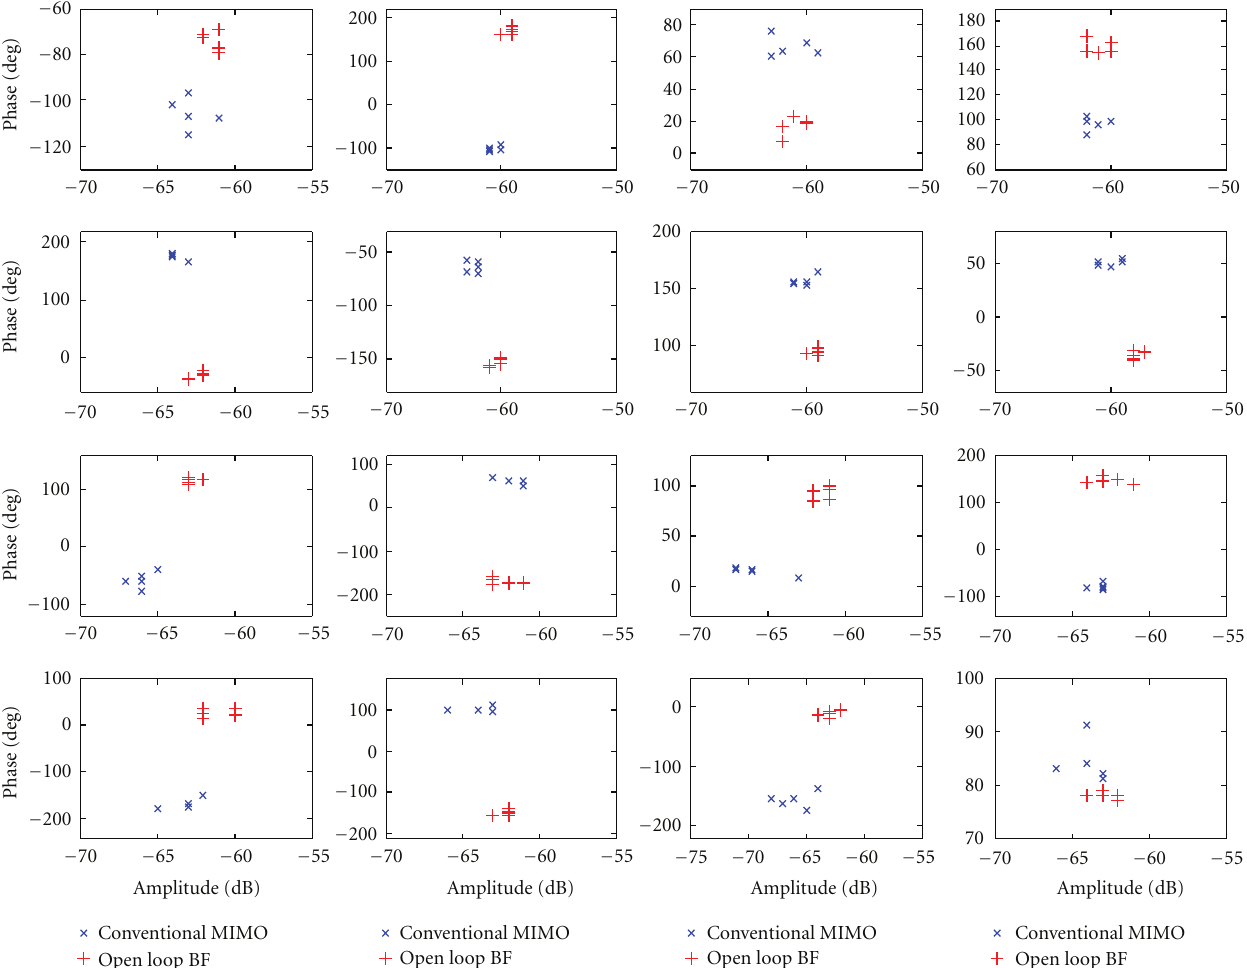
Figure 9: Measured 4 × 4 MIMO channels of conventional MIMO system and open loop beamforming (Butler matrix), at location 5. Table 4: Average capacity (bps/Hz) of all locations when rotating the direction of array antennas for SNR = 10 dB. Location